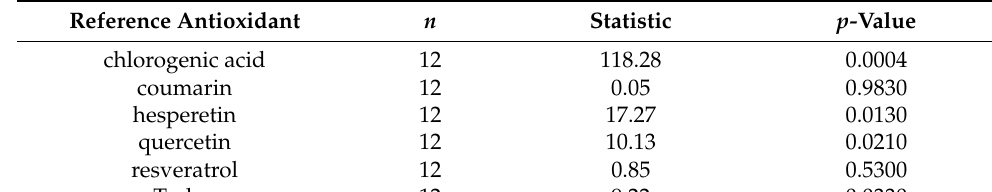
Table 3. Welch ANOVA test results for each reference antioxidant.